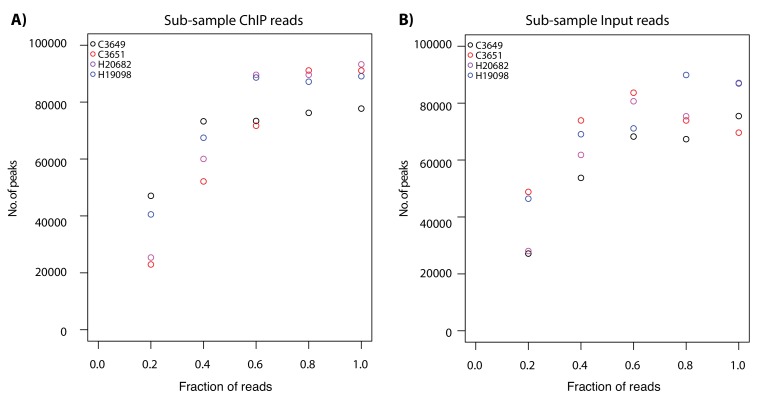
ChIP-seq peak numbers approach saturation with increasing read depth.(A) Number of H3K9me3 ChIP-seq peaks called at a FDR of 10% while sub-sampling the number of ChIP-seq reads from C3651 (red) and H19098 (blue) (~15 million total reads), and C3649 (black) and H20682 (purple) (~9 million total reads). (B) Number of H3K9me3 ChIP-seq peaks called at a FDR of 10% while sub-sampling the number of Input reads from C3651 and H19098 (~35 million total reads), and C3649 and H20682 (~16 million total reads).